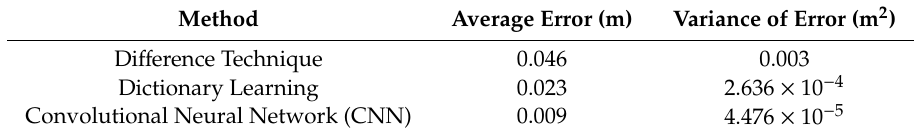
Table 2. Comparison of the average and variance of error for di ff erent computer vision techniques